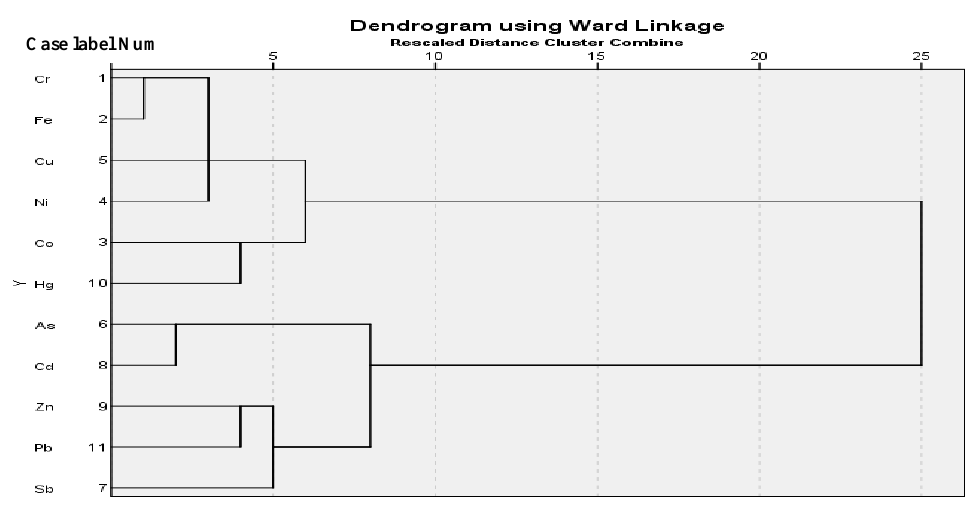
Figure 3. Dendrogram of hierarchal cluster analysis for trace elements in soil using Ward methods.